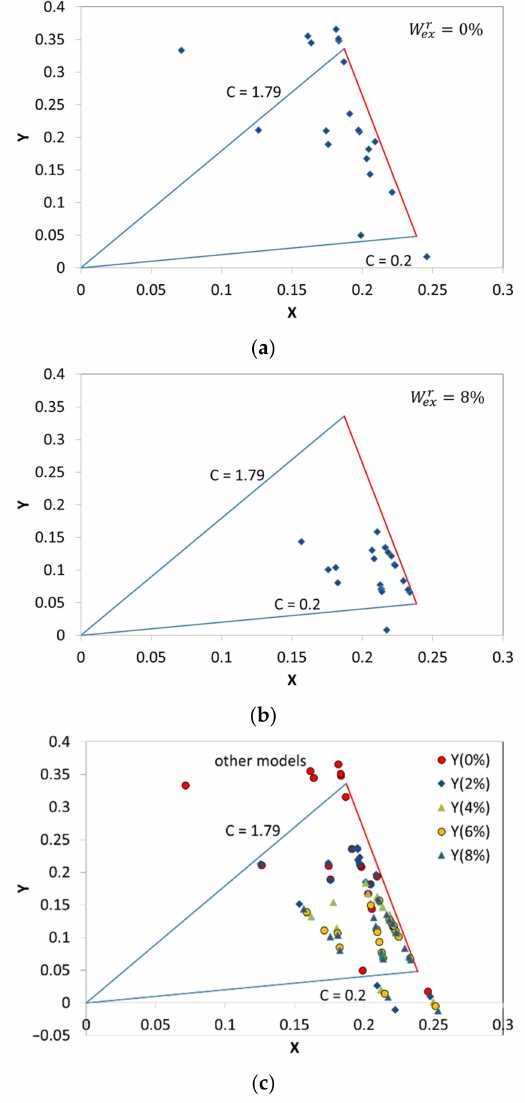
Figure 4. The arrangement of function scales for the triangle of grains of measurement data defining the bulk density obtained in the experiment planned according to [10] for: ( a ) W r ex = 0%, ( b ) W r ex = 8%, air-dry basis, ( c ) combined data for dla W r ex = 0; 2; 4; 6; 8% Source: authors own